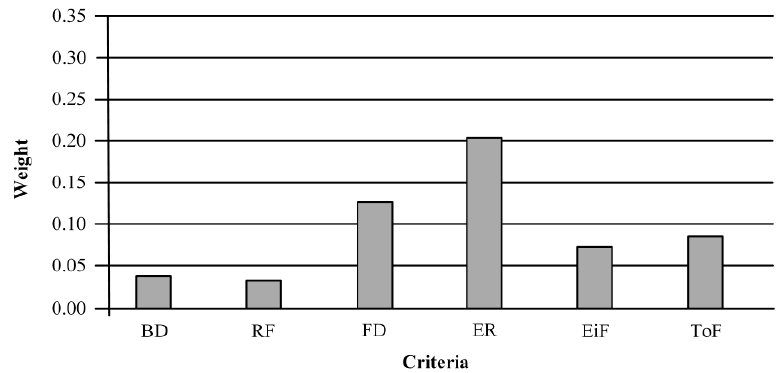
Fig. 8. “Energy block” criteria